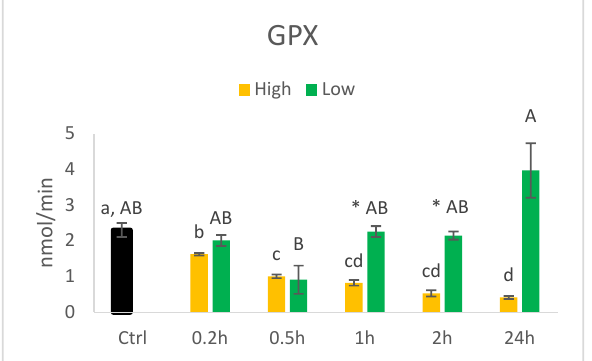
Figure 9. Activity (nmol/min) of GPX in HT29 cells exposed to high (140 µM) or low (0.014 µM) concentrations of HHE. Data (n = 4) are means shown with standard error mean. Significant differ- ences between control (Ctrl) and different time points within Low or High groups are indicated with different letters (High: lower letters, Low: capitalised letters) evaluated with Tukey–HSD ( p < 0.05). Significant differences between Low and High are evaluated by Student’s t -test and indicated with asterisk (*) at specific time